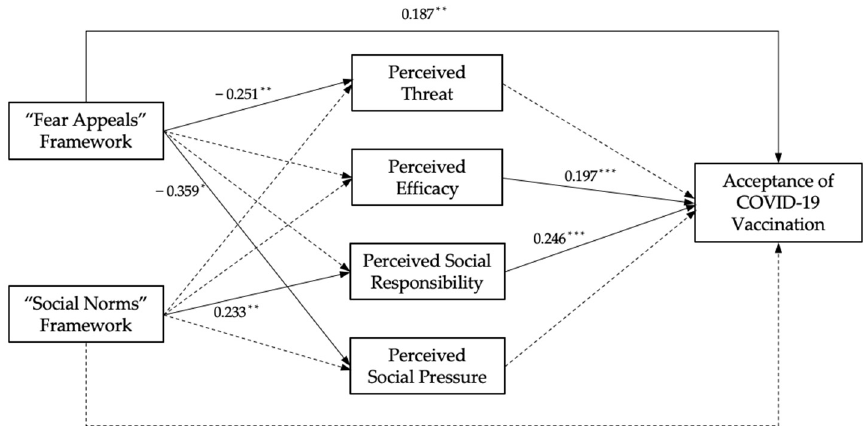
Figure 2. Hypothetical model test results, where solid lines represent established paths, and dashed lines represent untenable paths. All the established paths are marked with the effect value (B) (* p < 0.1, ** p < 0.05, *** p < 0.001).